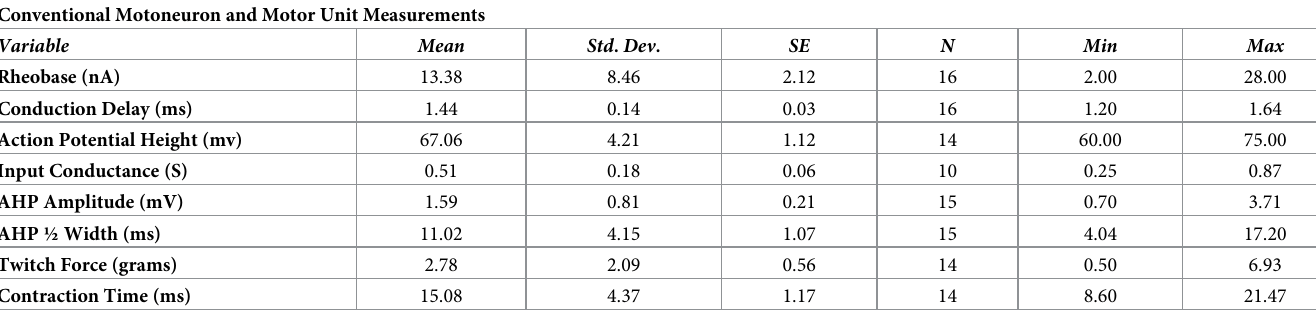
Table 3. Biophysical measurements from intracellularly recorded MG motoneurons. Conventional Motoneuron and Motor Unit